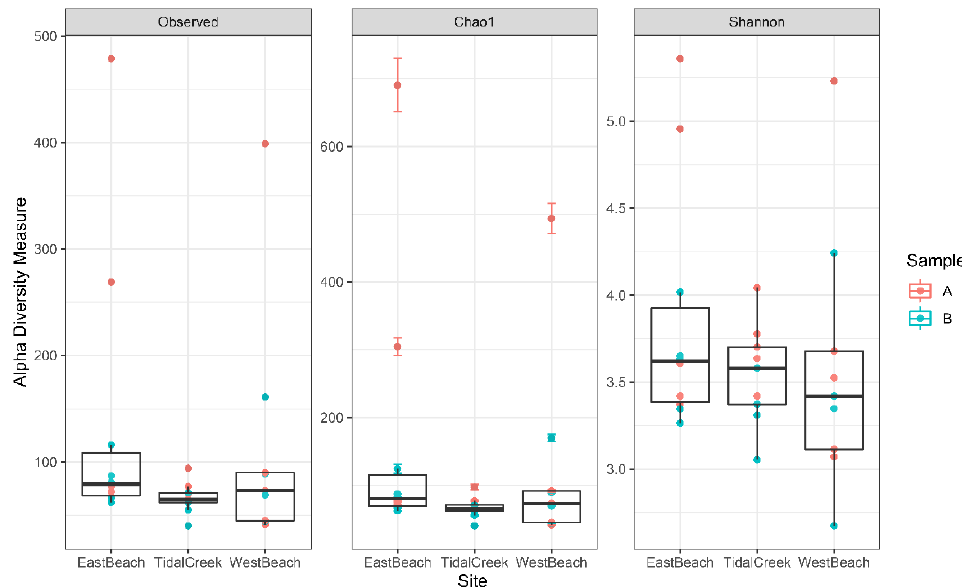
Fig. 4: Sediment alpha diversity metrics following normalization for the observed ASV (left) and the estimated richness with Chao1 (middle) as well as the Shannon-Wiener Diversity Index (right)